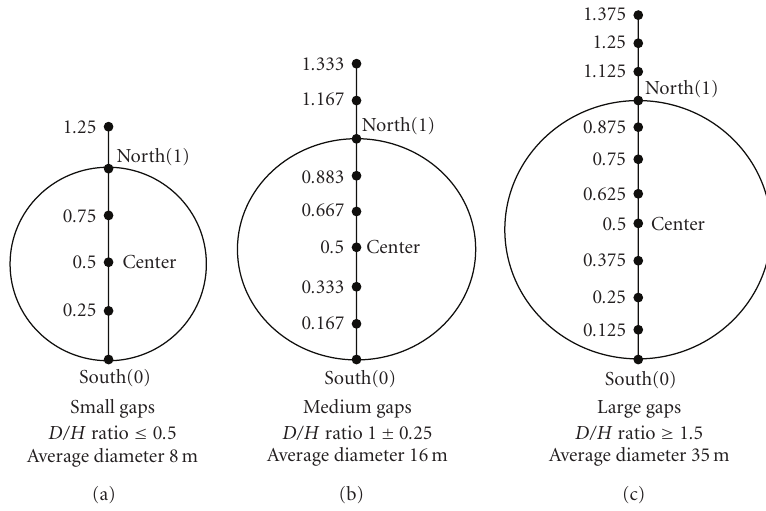
Figure 1: Measurement positions in gaps and under the canopy (north of gaps) for (a) small ( D/H ratio ≤ 0.5), (b) medium ( D/H ratio 1 ± 0 . 25), and (c) large ( D/H ratio ≥ 1.5) sized gaps. The average diameter of the five gaps evaluated for each category is presented to give a reference to the distance between measurement